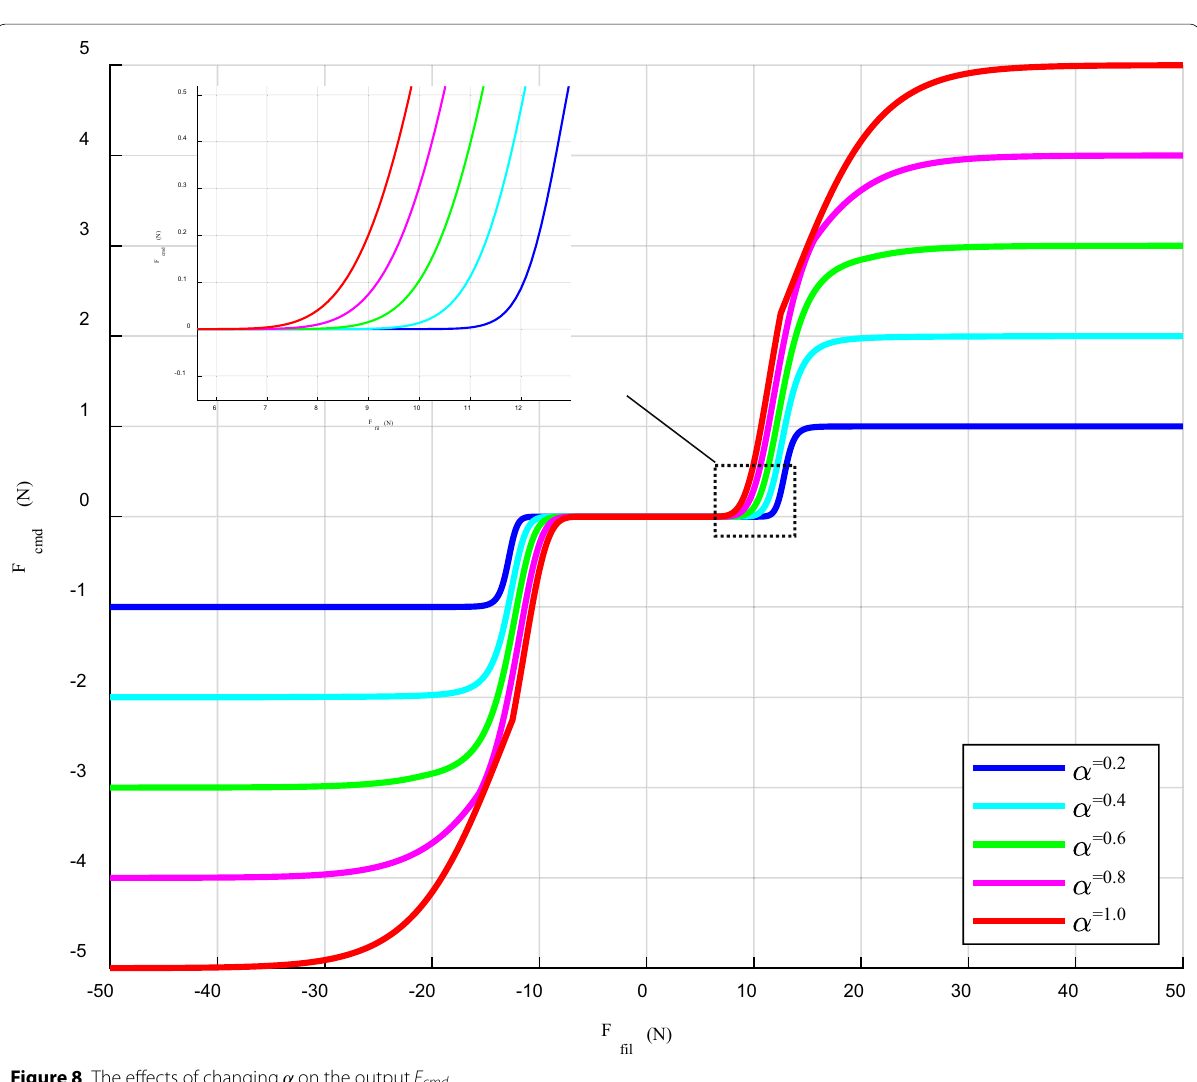
Figure 8 The effects of changing α on the output F